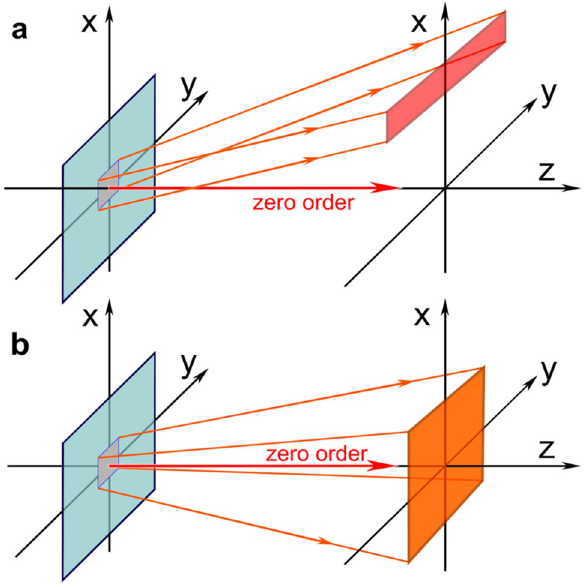
Figure 1. Scheme for observing 3D image: ( a ) formed by rainbow hologram and ( b ) in the vicinity of zero